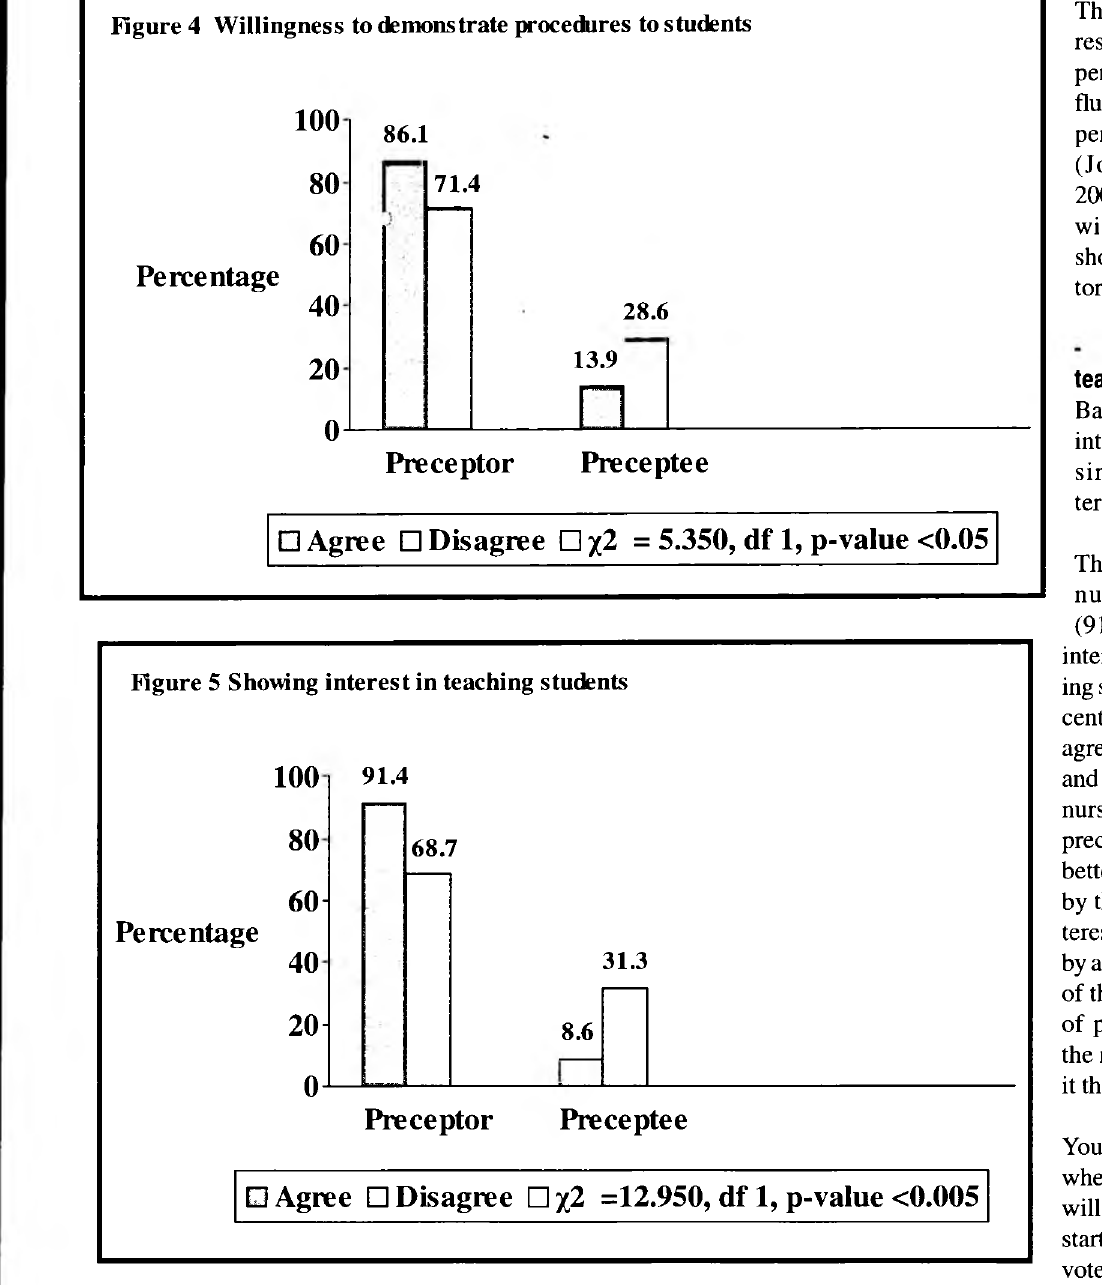
Figure 4 Willingness to demonstrate procedures to students